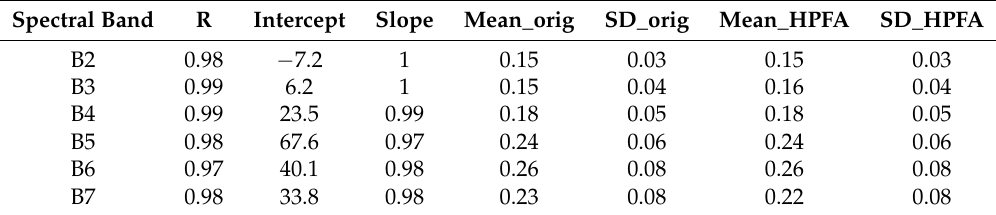
Table 2. Correlation analysis results of L8 image dated 26 February 2016. R (correlation coefficient), Intercept and Slope are linear regression outputs, Mean_orig and SD_Orig are mean and standard deviation of original spectral bands, respectively; and Mean_HPFA and SD_HPFA are mean and standard deviation of resampled spectral bands, respectively.